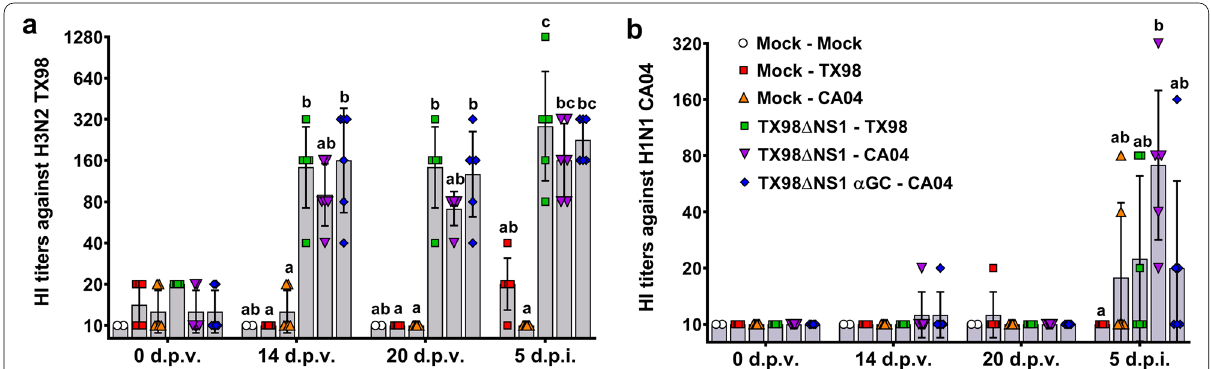
Fig. 3 Virus-specific antibody titers. a , b Geometric mean of hemagglutination inhibition titers against TX98 ( a ) and CA04 ( b ) antigens in sera collected at 0, 14, and 20 d.p.v., and 5 d.p.i.. Differences between treatments were analyzed using a Dunn’s multiple comparison test. A statistically significant difference between two groups is indicated by different letters. Data are represented as geometric mean deviation. Symbols represent individual